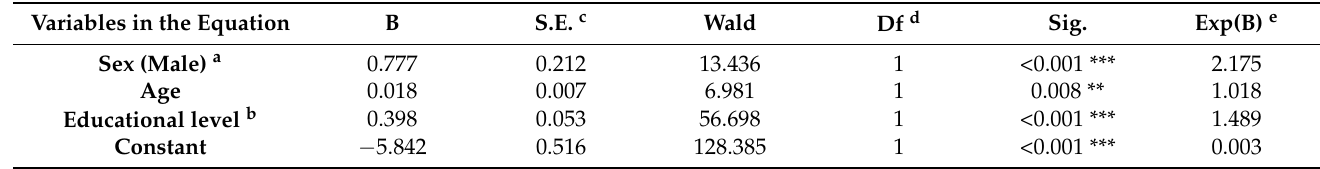
Table 1; c Standard Error; d Degrees of Freedom; e Odds Ratio (OR) *** Significant at the level p < 0.001; ** Significant at the level p < 0.010. The final solution presented an overall accuracy percentage of 91.0%, explained 19.1% of the variance among subjects (Nagelkerke’s R 2 = 0.191) and showed a − 2Log-likelihood coefficient of 690.412. The basic parameters and variables included in the model are presented in Table 5, showing its Beta coefficients, significance level and odds ratio